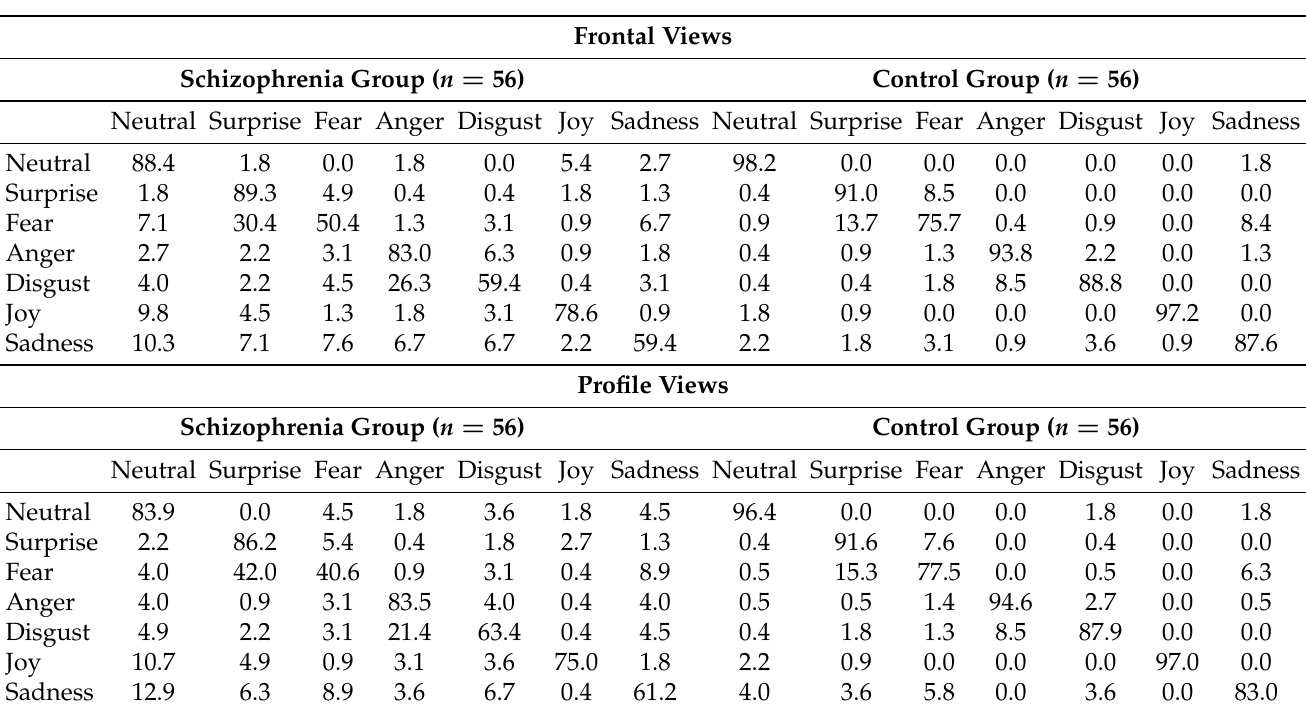
Table 5. Confusion matrix of emotion recognition (%) using frontal and profile views of the DVFs for the schizophre- nia